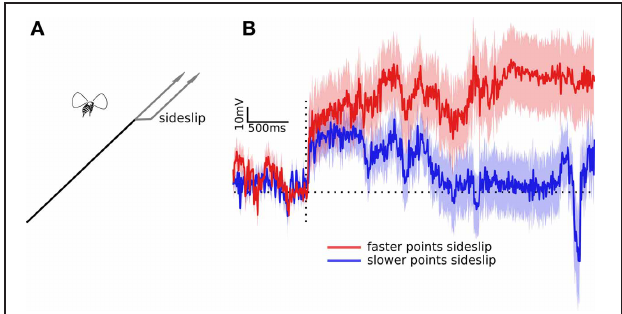
FIGURE 2 | Wing beat responses to two partial impulses in sideslip. (A) Optic flow of dots simulates two conflicting paths, some dots indicate forward motion, others indicate forward motion with an abrupt sideways deviation. The actual experimental perturbations were randomly to the left or right. (B) The traces illustrates the difference between the left and right wing beat amplitudes. The red trace shows the response to the faster dots (apparently nearer) deviating to the side, while the blue trace is the response to the slower dots (apparently farther) deviating to the side. Traces are the means flanked by standard errors from the responses of 100 flies. The horizontal dotted line shows the response level when left and right wing beat amplitude are equal, the vertical dotted line is the time point of the lateral